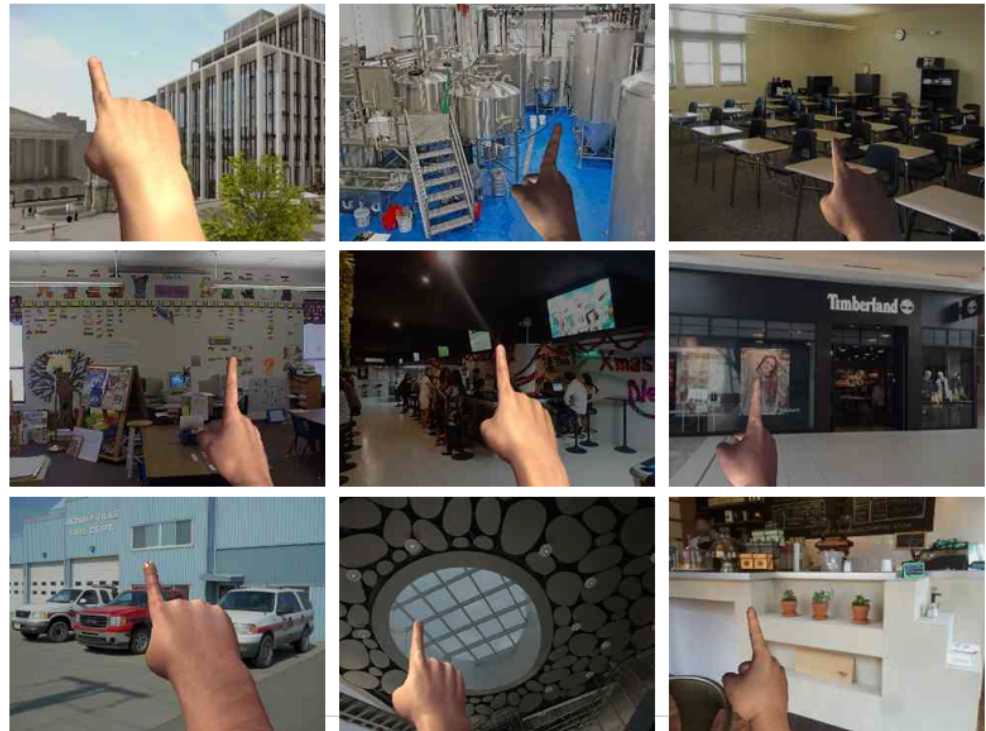
Figure 9. Image samples from our synthetic